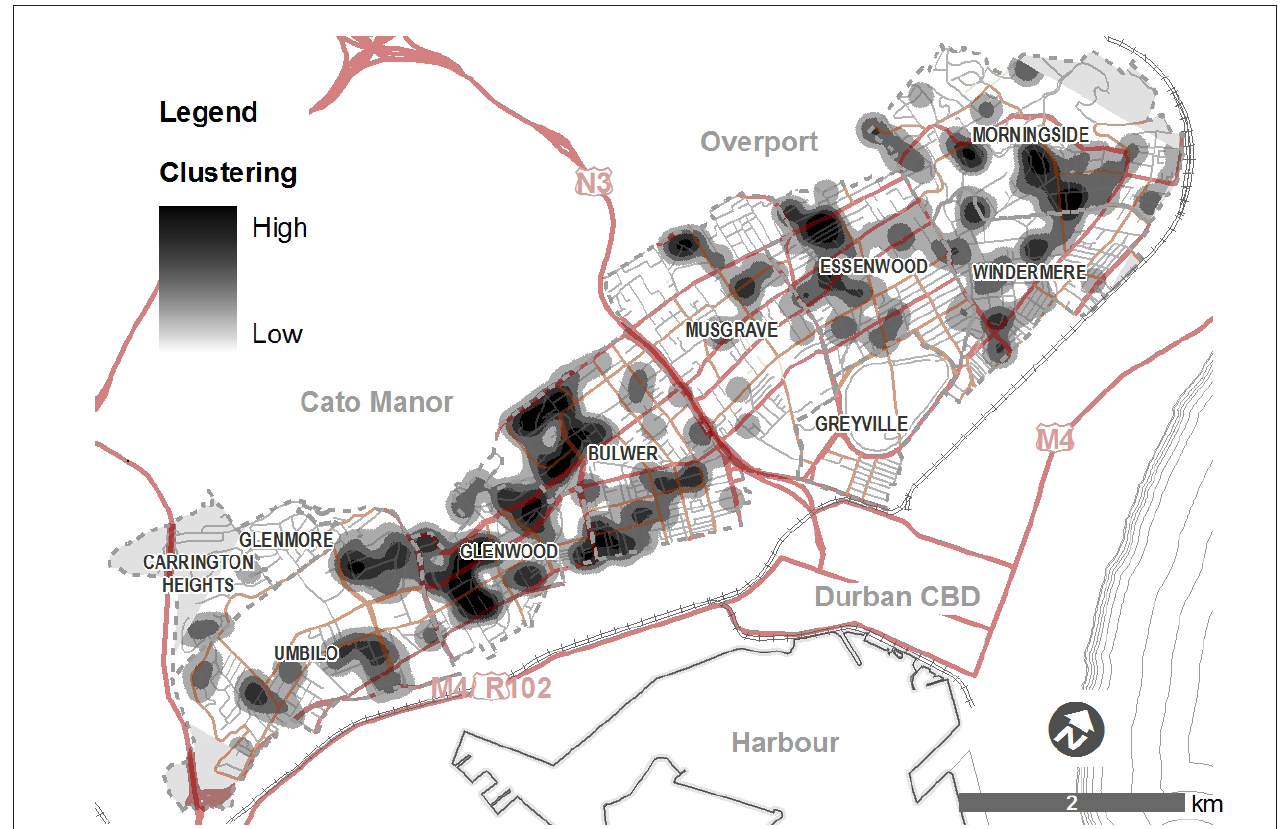
Figure 5: Distribution of business application on the Berea 2012-2016 Source: Adapted from eThekwini Municipality Central Durban Application Register by DUT GIS Unit,